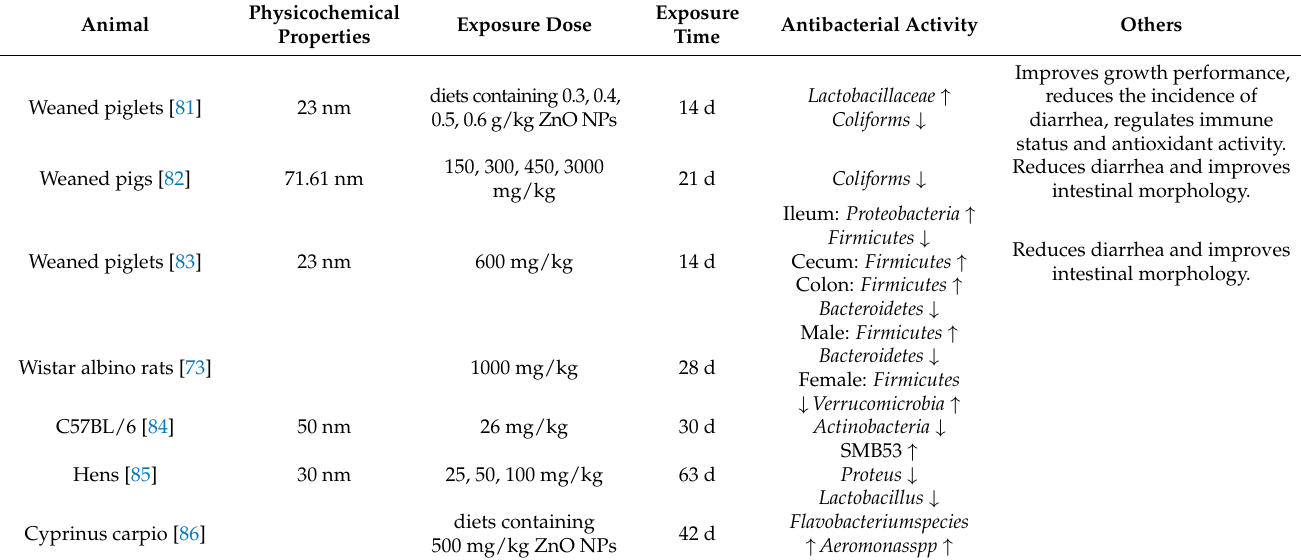
Figure 4 . Effects of ZnO NPs on gut microbiota. The SEM ( A , B ) and TEM ( D , E ) images of E. coli treated without ZnO NPs ( A , D ) and 20 mM ZnO NPs ( B , E ). White arrows indicate ZnO NPs. Scanning electron microscopy scale bar = 1 µ m, TEM scale bar = 0.2 µ m. Reproduced with permission [79]. Copyright 2021, MDPI. ( C ) ZnO NP antibacterial mechanism and influencing factors schematic diagram. Reproduced with permission [80]. Copyright 2020, Dovepress. Table 3. Effects of ZnO NPs on gut microbiota.